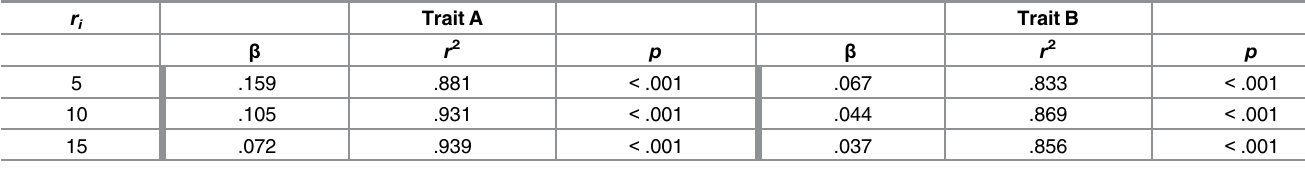
n = 90 runs in each